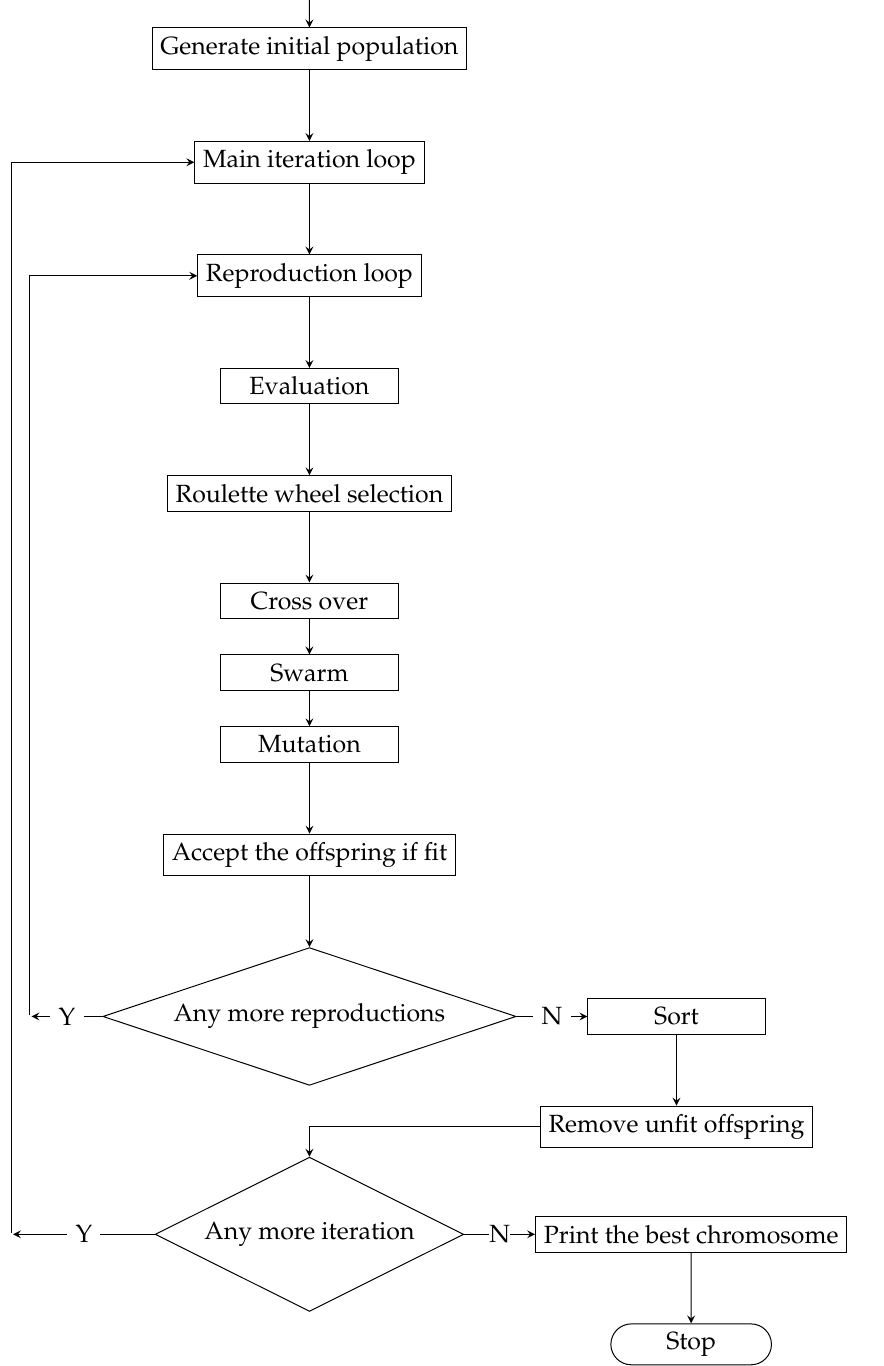
Figure 2. Flowchart depicting the GA-Swarm